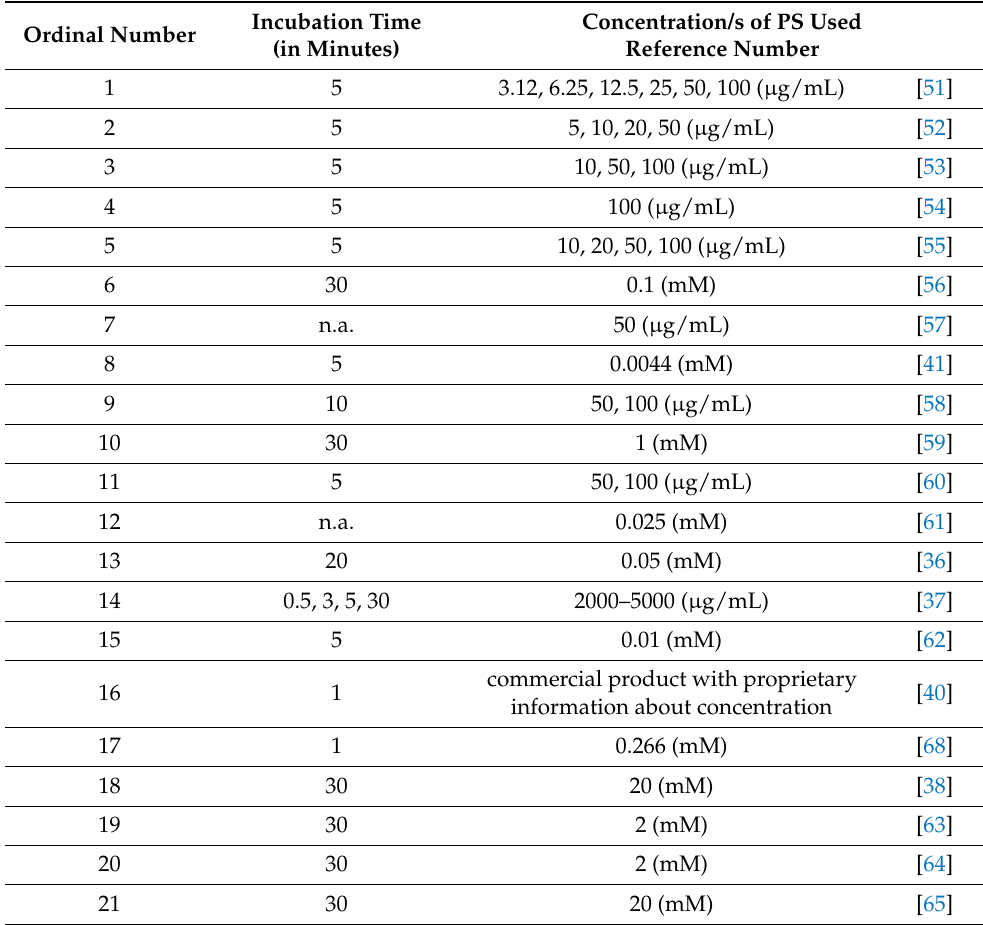
Table 4. Characteristics of TBO used in studies that fulfilled eligibility criteria. Ordinal